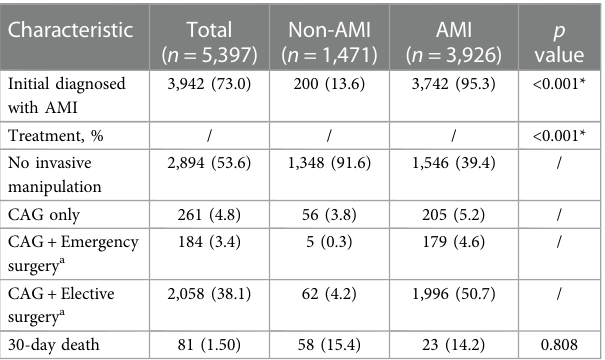
TABLE 2 Management of all patients.